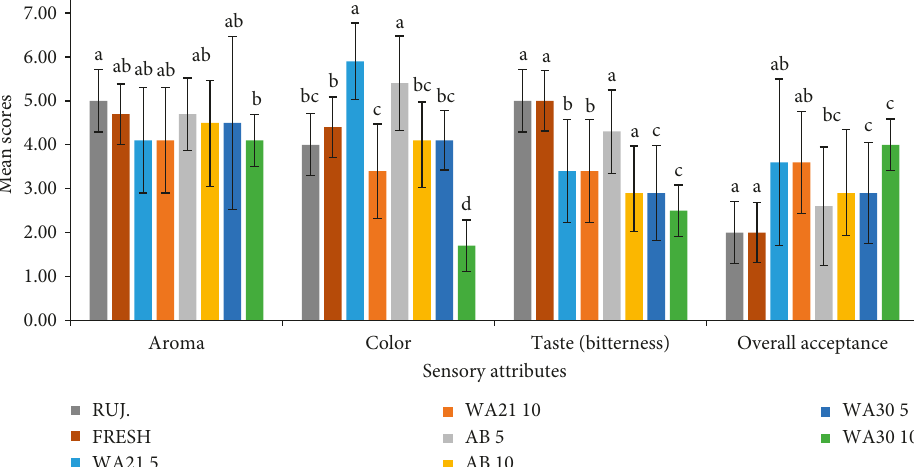
Figure 9: CIE L a b reading by the Minolta Chromameter on fresh (untreated) and treated C . papaya leaf extracts. a–f: different alphabets indicate a significant difference ( p 0 . 05). ∗ ∗ ∗ <